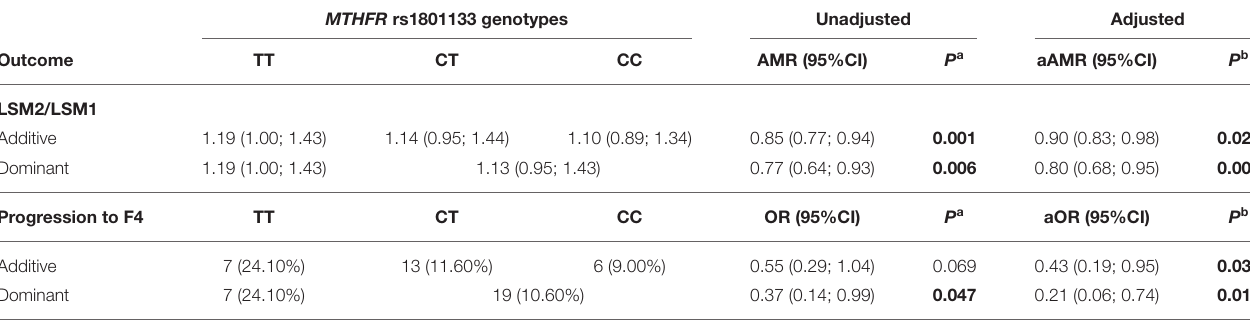
TABLE 4 | Association between MTHFR rs1801133 polymorphism and progression of liver fibrosis in patients with chronic hepatitis C (longitudinal analysis). MTHFR rs1801133 genotypes